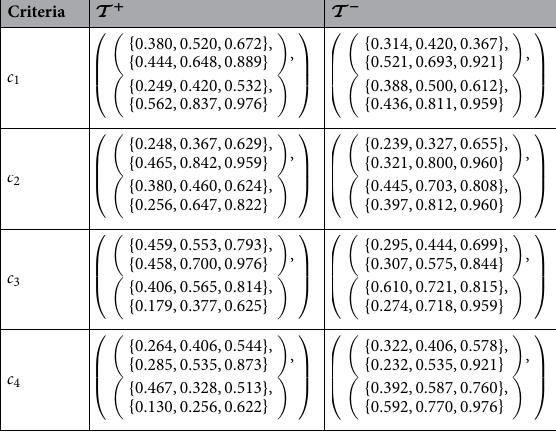
Table 10. The PIS and NIS based on FHFR information.